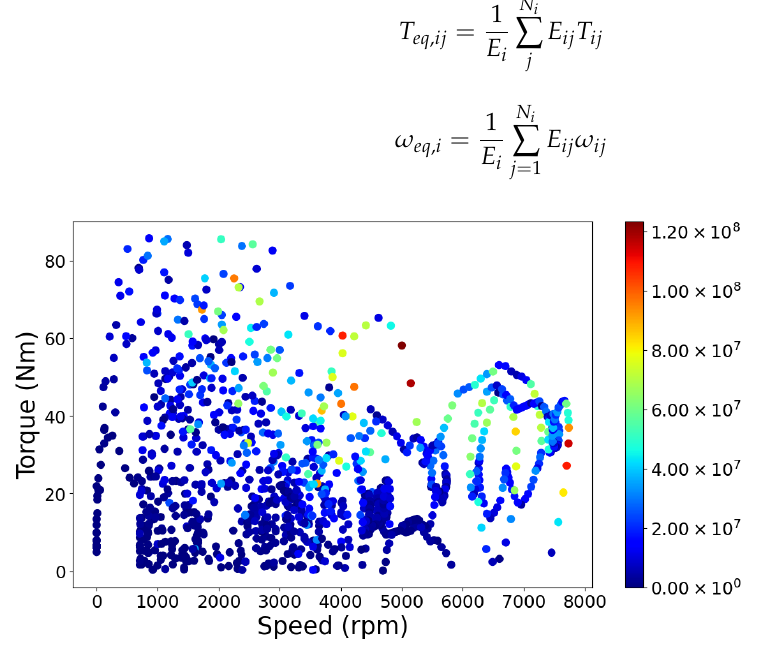
Figure 5. Load energy consumption over the WLTP drive cycle